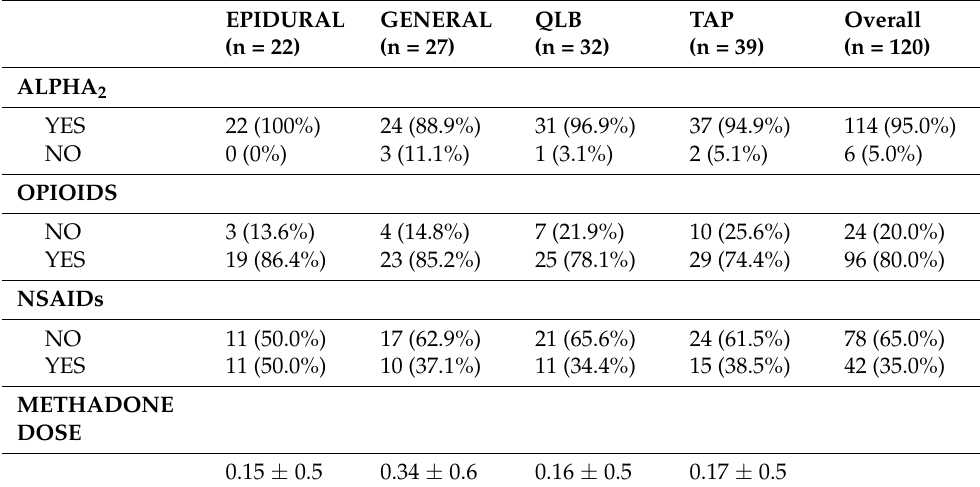
Table 2. Results on the cases that received alpha2 adrenergic agonists, opioids and NSAIDs for premedication in each group. There were no significant differences on the use of these drugs among the groups.